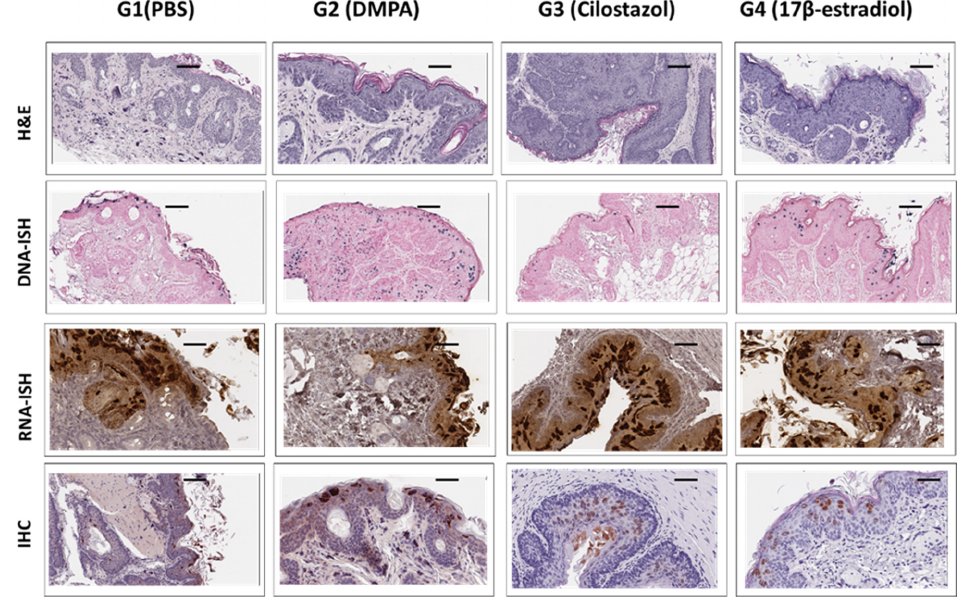
Figure 8. Comparable viral signals (RNA, DNA, and protein) were detected in anal tissues of different groups. Athymic Hsd:Nu Mice with equivalent weight were distributed into four groups (n = 5), treated with PBS (group 1), DMPA (group 2), Cilostazol (group 3), and17 β -estradiol (group 4) at one month post viral infection and treated up to nine months. Anal tissues were harvested for histological, virological, and immunological analyses. Representative images for each group are shown here. The top panel shows H& E staining. Viral DNA (the second panel), RNA (the third panel), and E4 protein (the bottom panel) were detected by in situ hybridization (ISH) and immunohistochemistry (IHC), respectively. Similar histology including mild to moderate dysplasia with persistent differentiation was found in all groups. No significant difference in viral signals was found among the four groups at the termination of the experiment nine months post treatment. Scale bar = 100 µm.